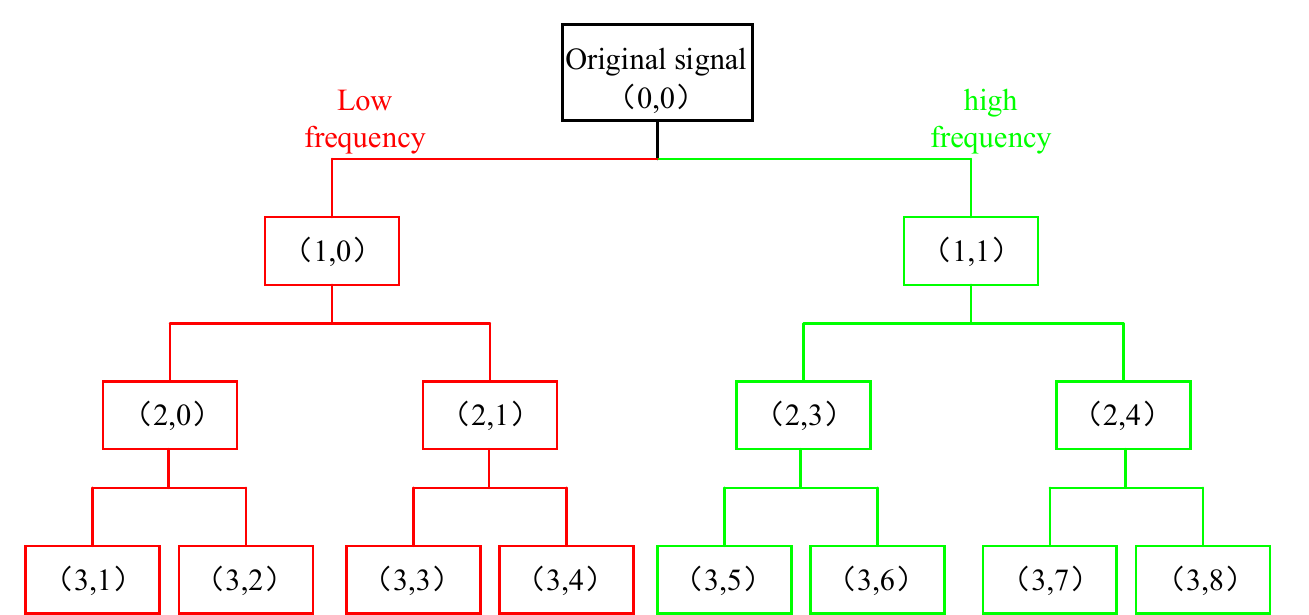
Figure 1. Decomposition diagram of three-layer wavelet packet.